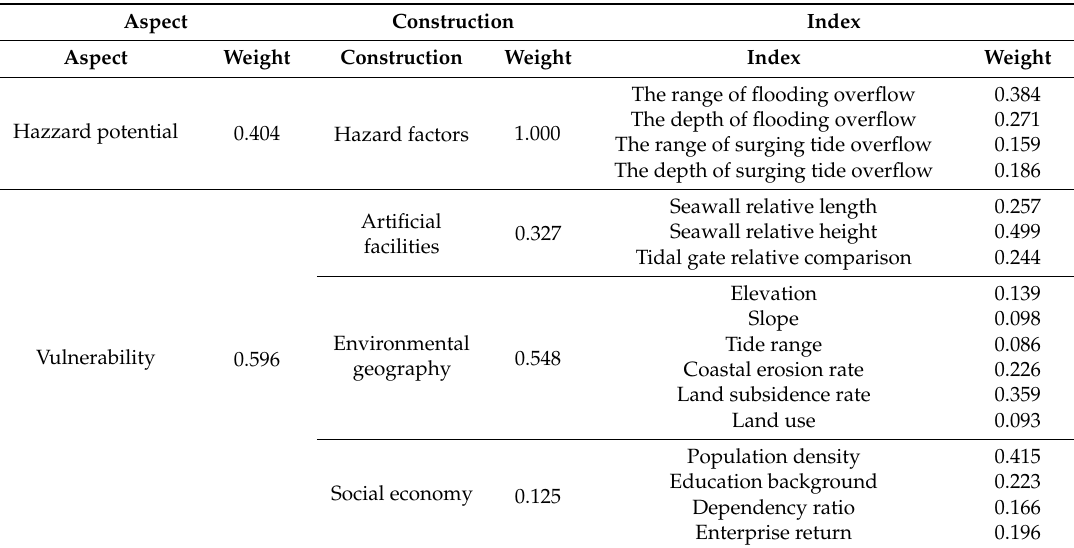
Table 1. The structures and weights of the coastal risk analysis based on the Analytic Hierarchy Process (AHP)